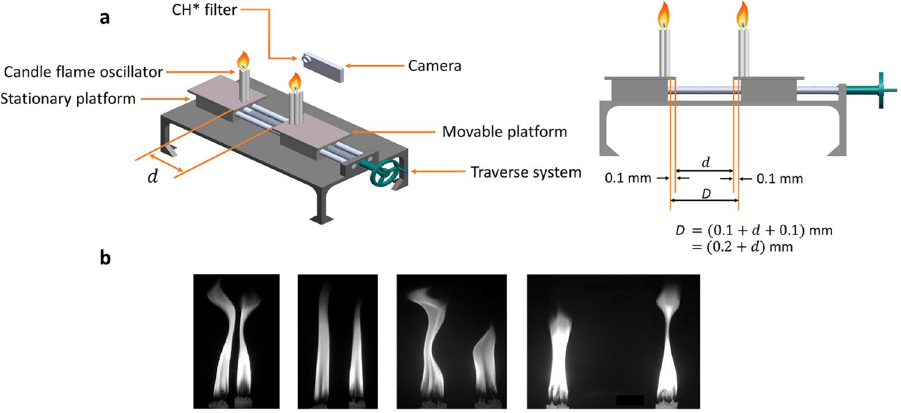
Figure 1. Experiment setup and flame images corresponding to different modes of coupled behaviour. (a) , Schematic of the experimental setup (isometric and side view) used for studying the coupled behaviour of a pair of candle-flame oscillators by varying the distance between them. One oscillator is mounted on a stationary platform and the other on a movable platform. The latter is moved with the help of a traverse system, thereby varying the distance ( d ) between them, which in turn, varies the edge to edge distance between the oscillators ( D ). High speed images of heat release rate fluctuations, at each value of d , were acquired using a camera with a CH * chemiluminescence filter mounted in front of it. Similar experiments were conducted by varying the number of candles in each oscillator from 3 to 8. (b) , Snapshots of the flame images as captured at characteristic distances between the oscillators highlighting the oscillatory states of IP ( d = 0 cm), AD ( d = 1 cm), AP ( d = 2 cm) and desynchronization ( d = 7 cm), respectively. A detailed description of the experimental setup